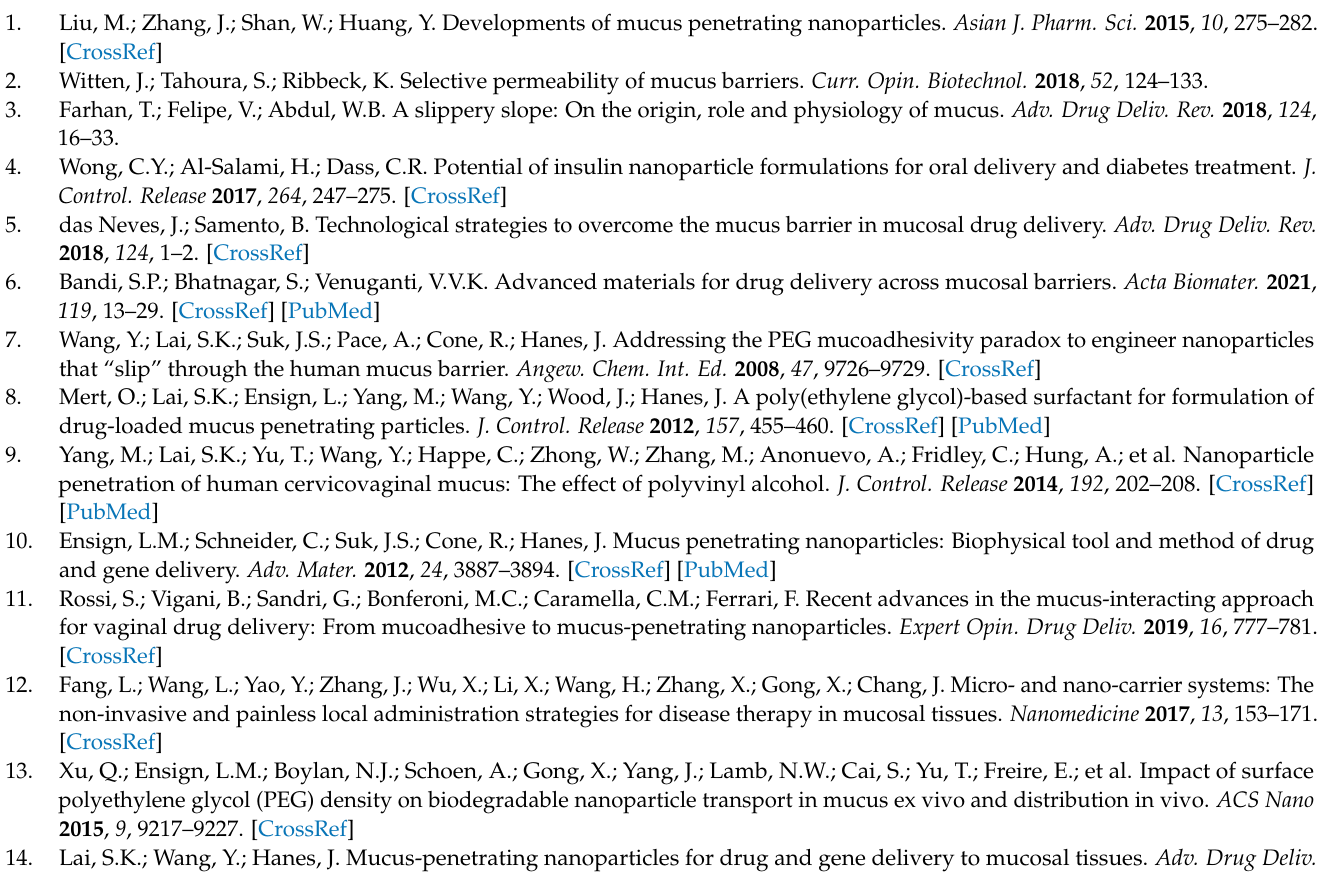
Figure S2: The electromagnet used to generate gradient magnetic fields; Figure S3: Characterization of Fe 3 O 4 nanoparticles and Janus nanovehicles; Table S1. Zeta potentials and particle size of the nanoparticles; Figure S4: Size distributions of Fe 3 O 4 nanoparticles and nanovehicles in HEPES (pH